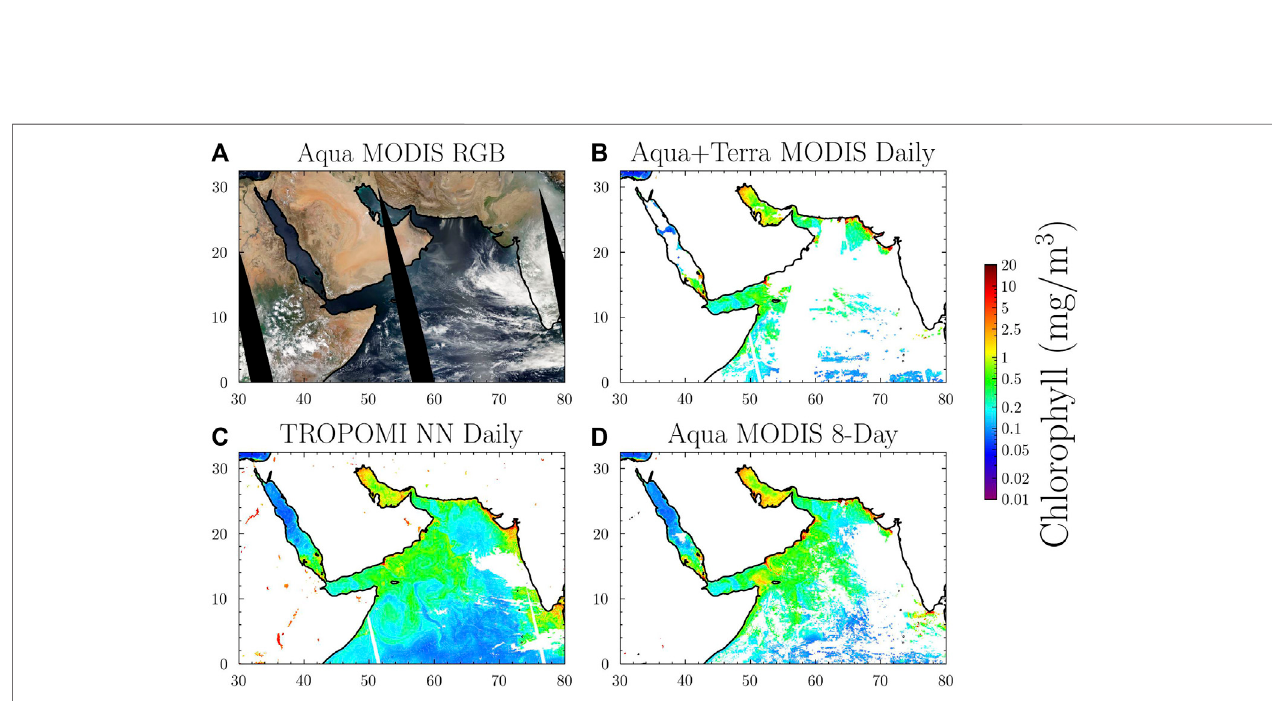
FIGURE 12 | Chlorophyll retrievals in the Arabian Sea on 13 October 2020. (A) shows a true color image from MODIS Aqua, (B) shows MODIS-Aqua daily 4 km retrieval, (C) shows TROPOMI machine learning – based chlorophyll, and (D) shows MODIS-Aqua 8-day composite of chlorophyll.